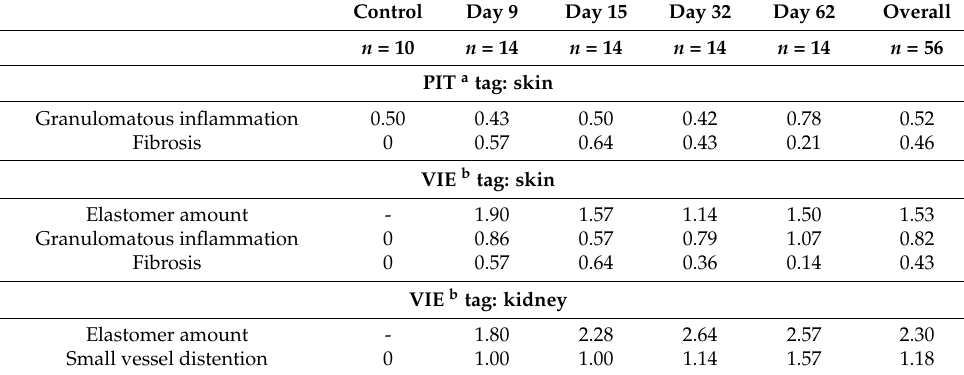
Table 1. Average numerical score for tag-associated histopathologic findings of marine toads ( Rhinella marina ) euthanized at four time points following PIT tag placement in the left caudal thigh and VIE tag placement in the right distal limb. Findings included the amount of VIE in each tissue, granulomatous inflammation, fibrosis, and small vessel distention, and each was assigned a score from 0–4; 0: not present, 1: minimal, 2: mild, 3: moderate, 4: marked. For each finding, the average score for all 56 tagged toads is reported in the overall